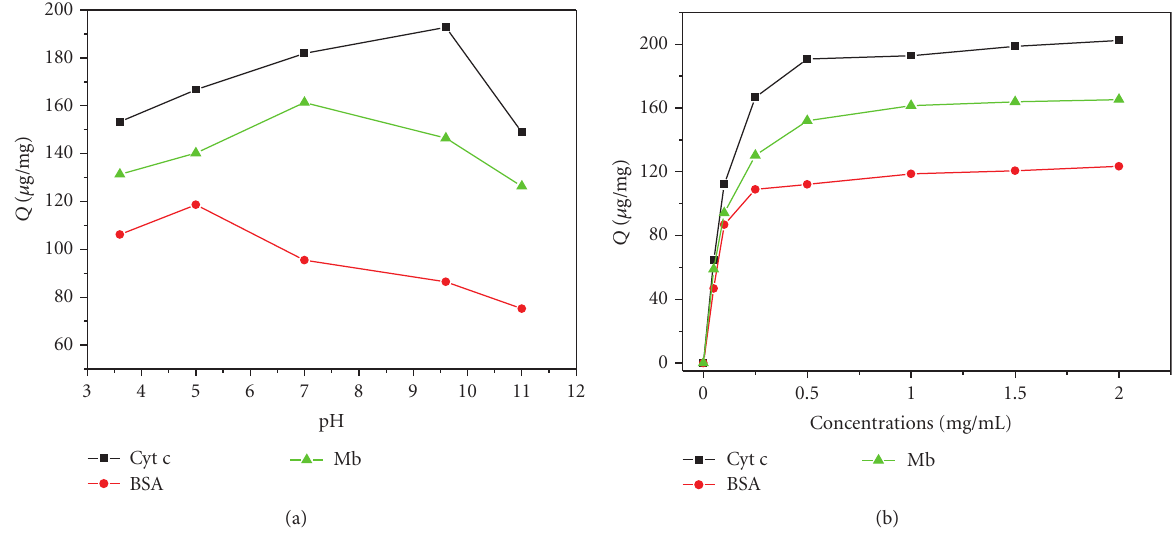
F 6: (a) the adsorption capacities of Cyt c, Mb, and BSA on magnetic mesoporous FePt/C composites with different solution pH ranging from 3.6 to 10.8 at protein concentration of 1.0mg/mL; (b) the adsorption curves of Cyt c, Mb, and BSA on magnetic mesoporous FePt/C composites with the solution at a pH equal to the pI of each protein